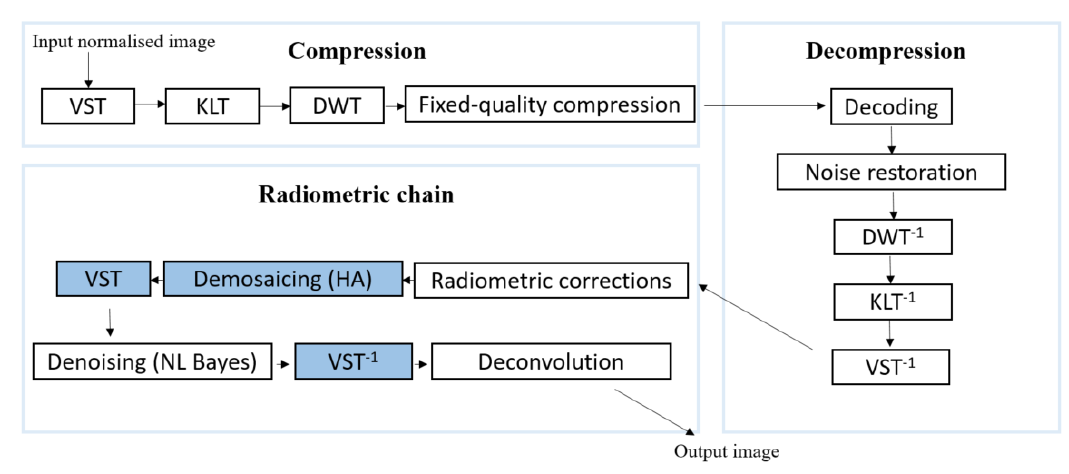
Figure 7. Block diagram of the overall image processing chain. Only the steps discussed in this paper are shown (normalisation is for instance considered for the input image, but not shown). The blocks filled in light blue colour are specific to matrix-based